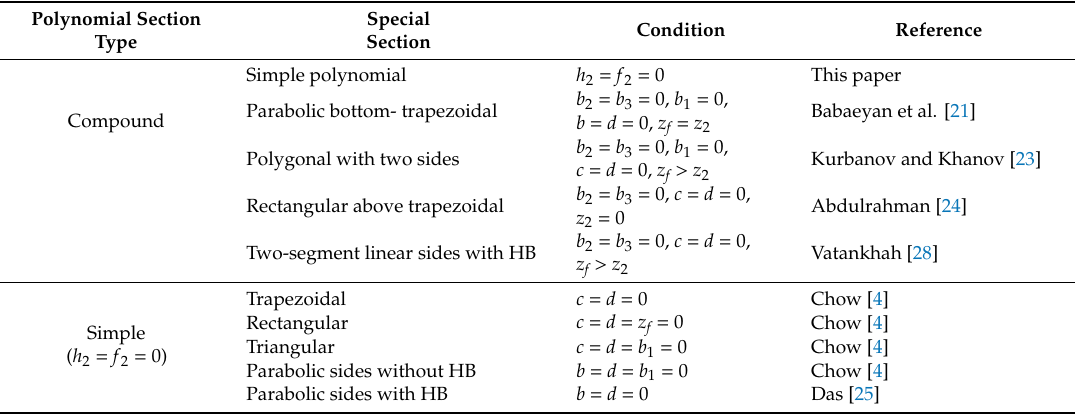
Table 2. Special cases of compound and simple polynomial